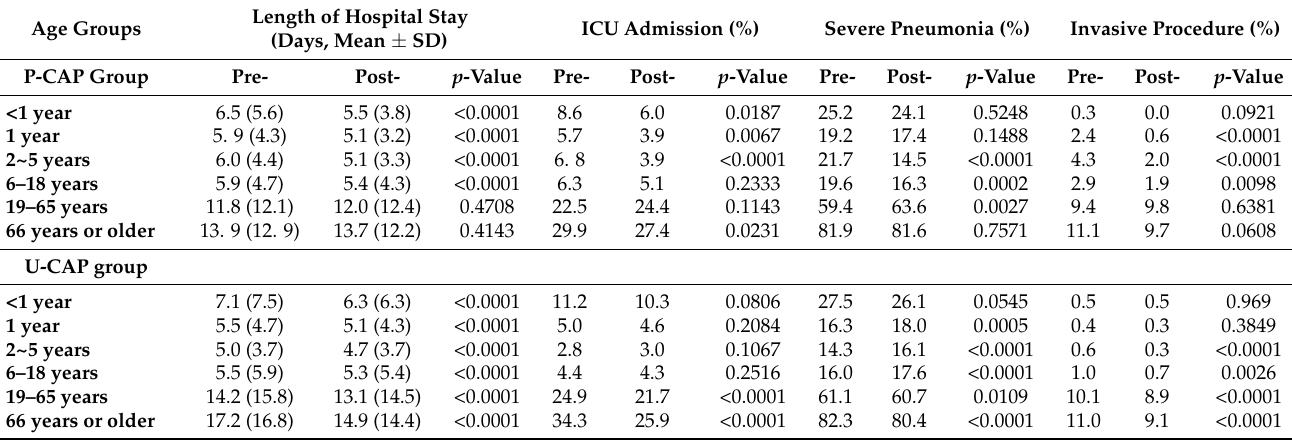
Table 2. Difference of clinical allocation and outcome between pre- (2005–2012) and post-vaccination period (2013–2016) among patients with pneumococcal and unspecific community-acquired pneumonia by age groups. Age